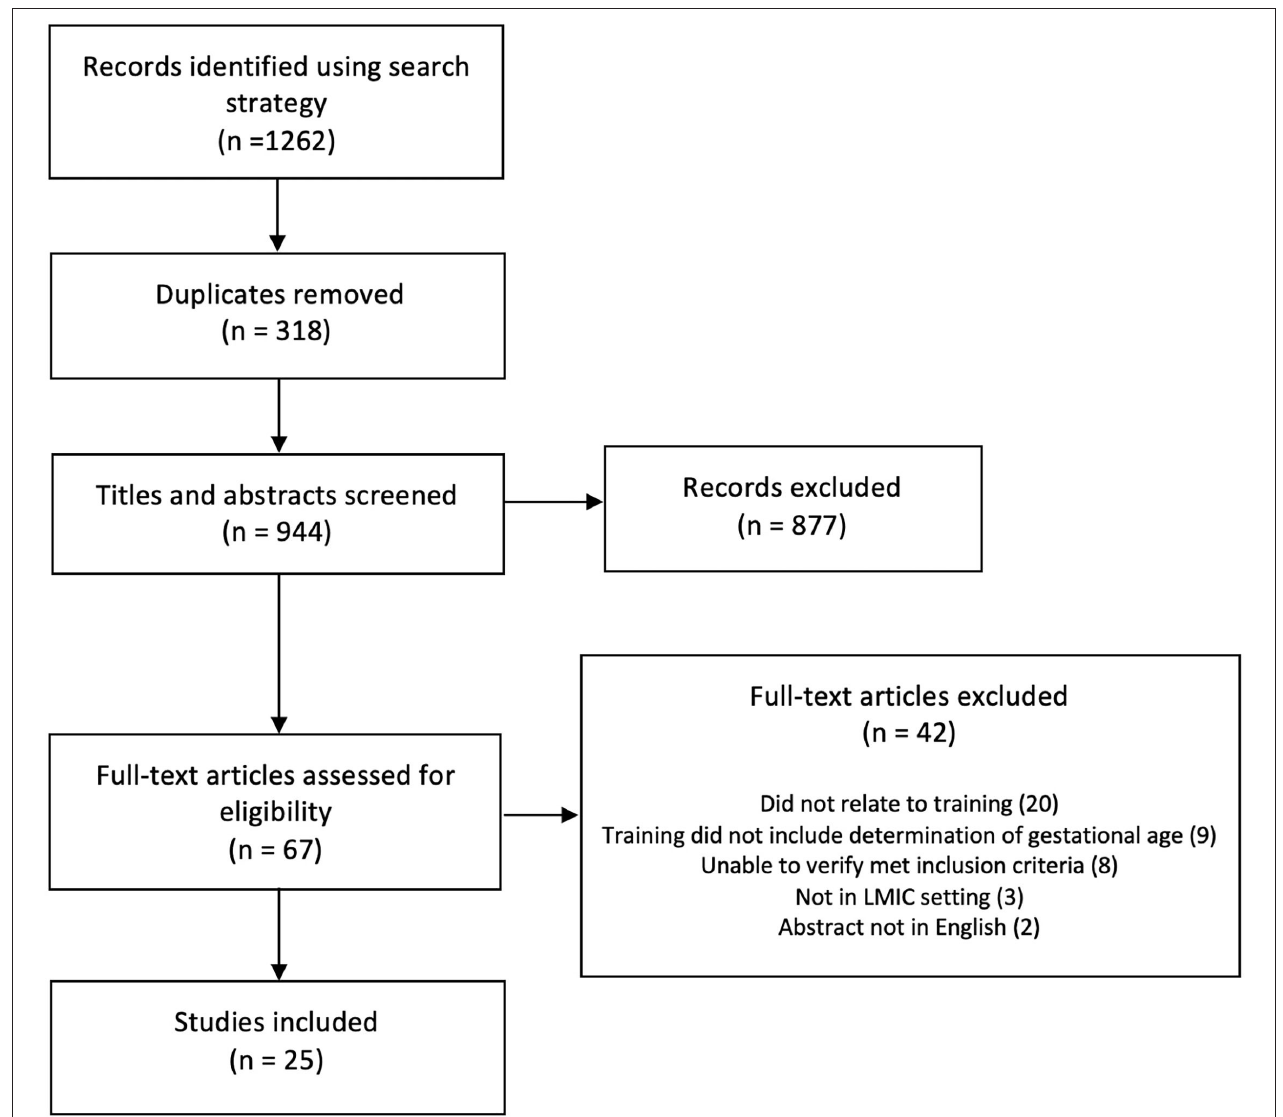
FIGURE 1 | PRISMA